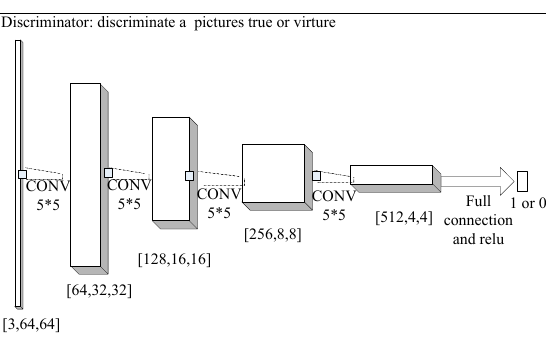
Figure 4. The algorithm of minibatch stochastic gradient descent.